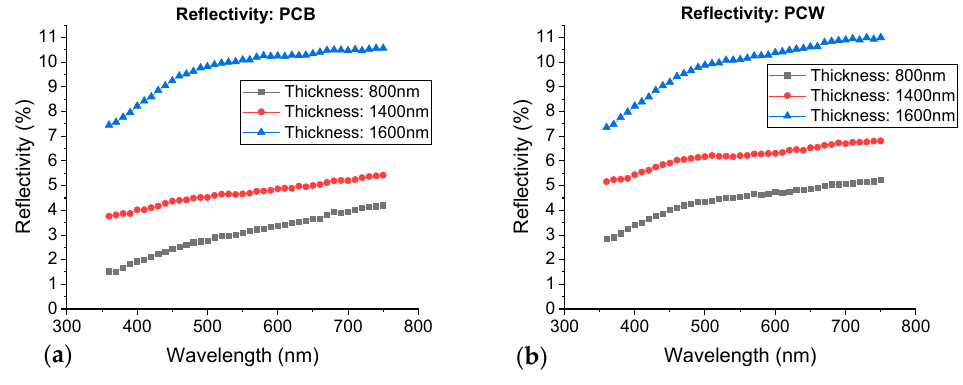
Figure 11. Diffuse reflectivity of Cr coatings deposited over: ( a ) PCB and ( b ) PCW.